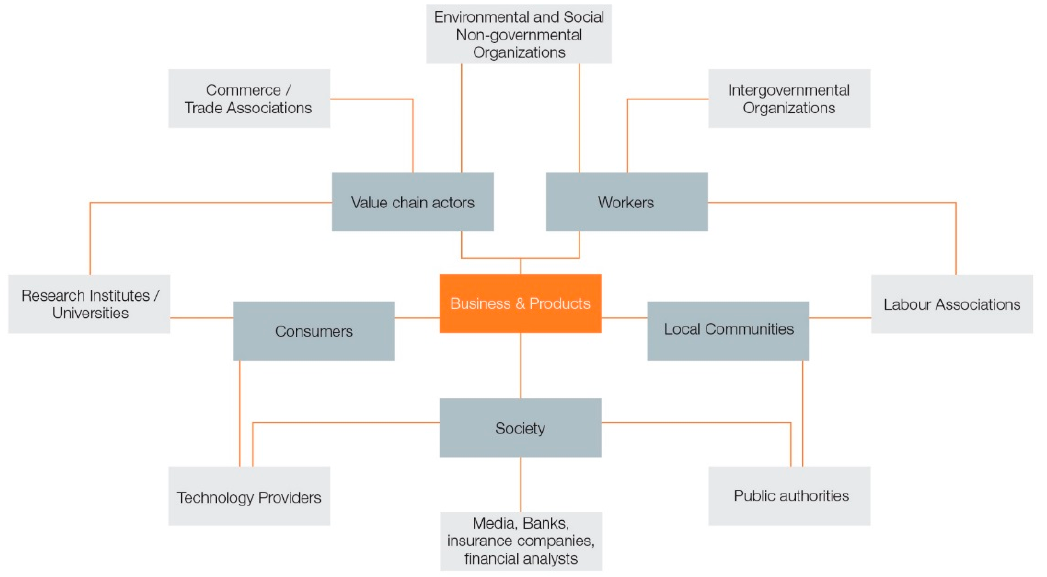
Figure 7. Stakeholder categories and sub-categories of the ceramic supply chain.